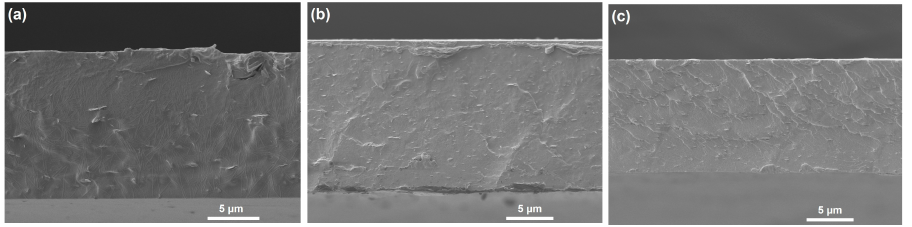
Figure 10. Cross-section SEM images of ( a ) PVA/BNNSs, ( b ) PVA/BNNSs-OH, and ( c ) cPVA/BNNSs- OH nanocomposites.